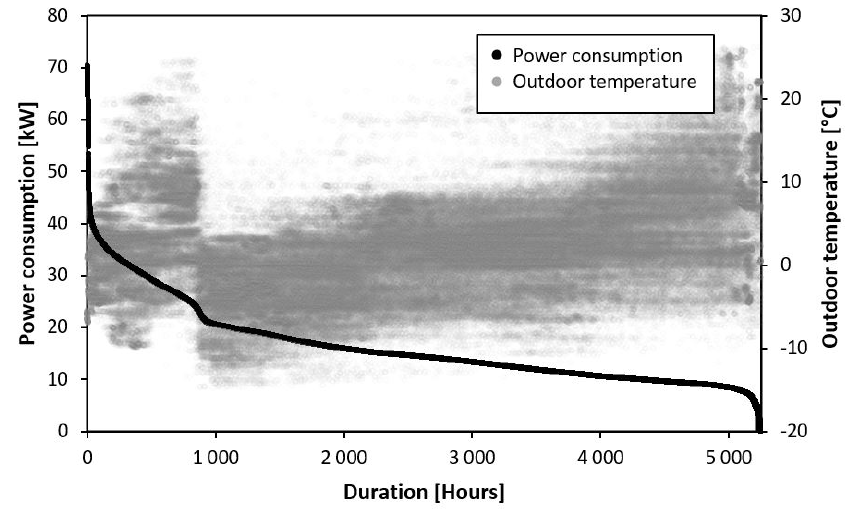
Figure 6. Scatter plot—sorted power consumption presented as a duration curve along with the corresponding outdoor